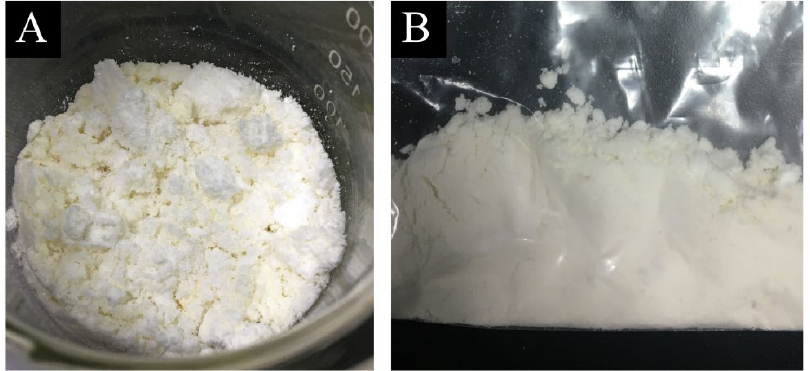
Figure 2. Macro morphology of the microcapsules: ( A ) the microcapsules before grinding, ( B ) the microcapsules after